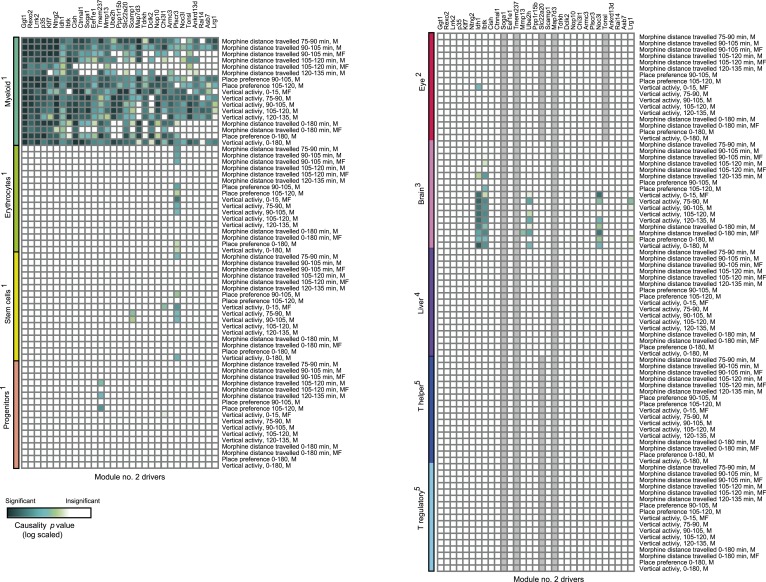
Causative relationships of module no. 2 across multiple tissues.Significance of causative relationships (blue, high; white, low) among traits (rows) vs the expression of driver transcripts (columns) in nine different tissues or cell types (color coded). In all cases a representative variant in the genomic interval of the module was used for analysis of causality (see Supplementary file 1C). Myeloid cells are shown at the top, indicating that causality relationships in this module are observed in myeloid cells, but hardly if at all in other tissues. Source data: 1Gerrits et al., 2009; 2Geisert et al., 2009; 3Mozhui et al., 2012; 4Gatti et al., 2007; 5Alberts et al., 2011.